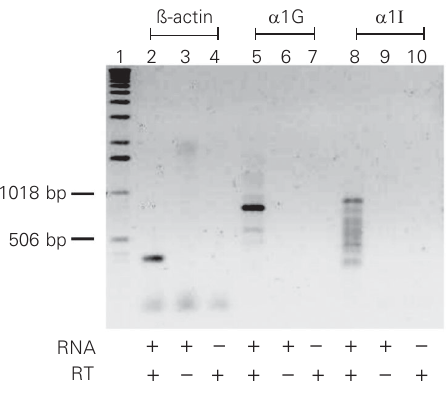
Figure 5. Exponential fits to tail currents. Records are from Figure 4B on an expanded time scale. The thicker smooth gray lines are fits to a single exponential (A, left) or the sum of two exponentials (B,